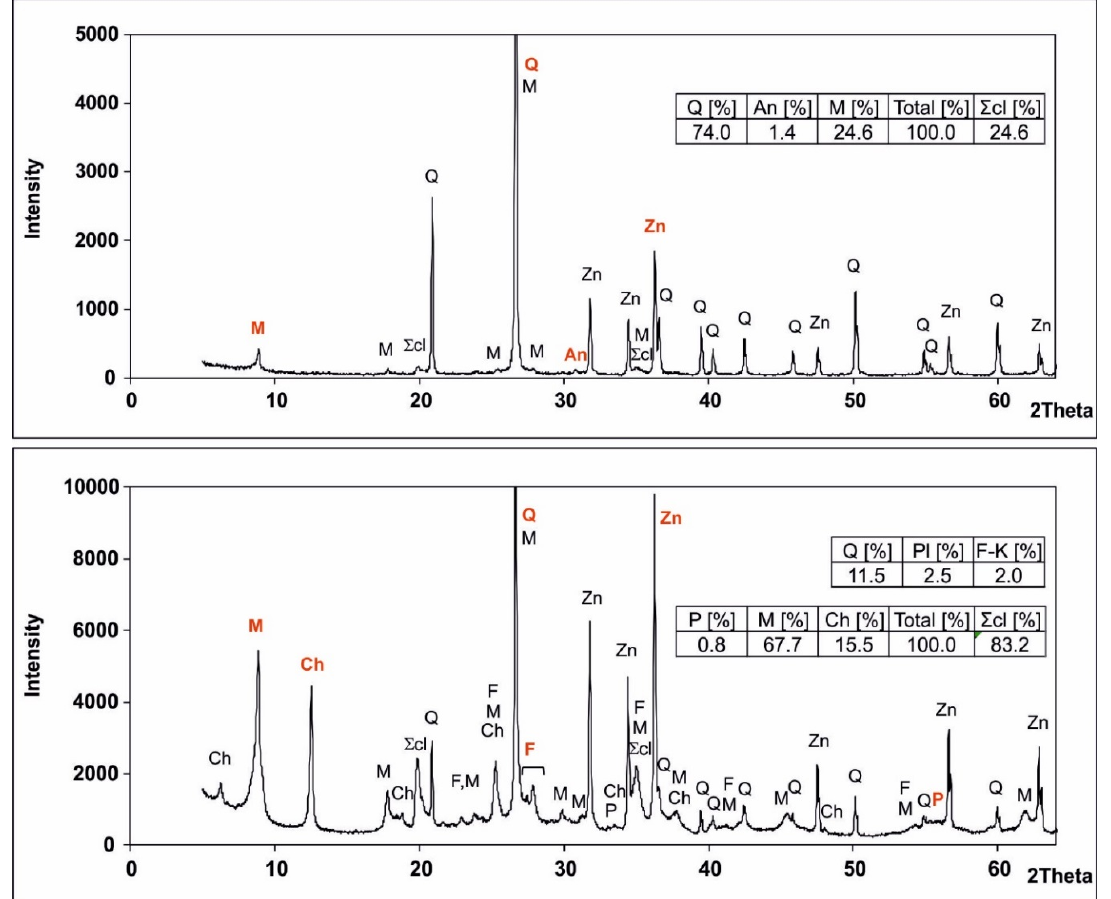
Figure 8. Exemplary XRD patterns for samples from the Kobylin-1 borehole. An example of a typical quartzite (upper) and clay-rich (lower) sample. Explanations: Q—quartz; F—feldspars; Pl—plagioclase; F-K—potassium feldspars; An—ankerite; M—micas and illite group clay minerals; Ch—chlorite; Σ cl—sum of clay minerals; Zn—zincite